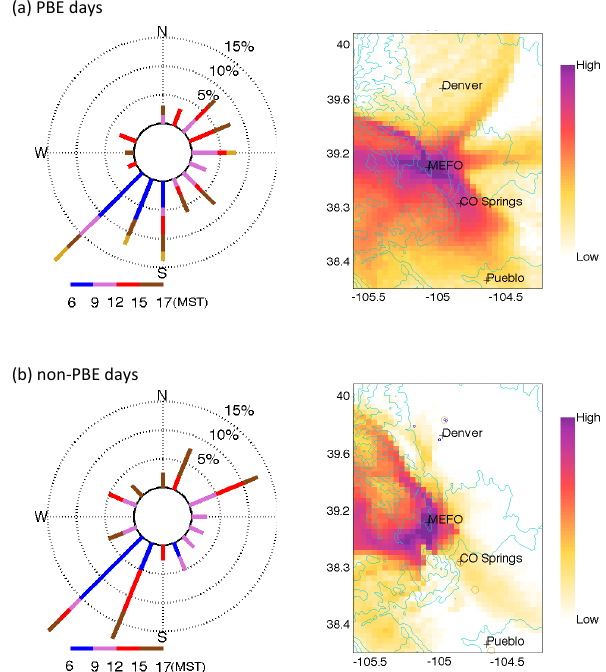
Figure 5. Wind fields for PBE days (a) and non-PBE days (b) : left panels are wind roses of local wind variations at 30m height plotted by hours of day at MEFO from 06:00 to 18:00MS. Right panels are regional wind preferred directions corresponding to local wind roses respectively, based on WRF-FLEXPART analysis.